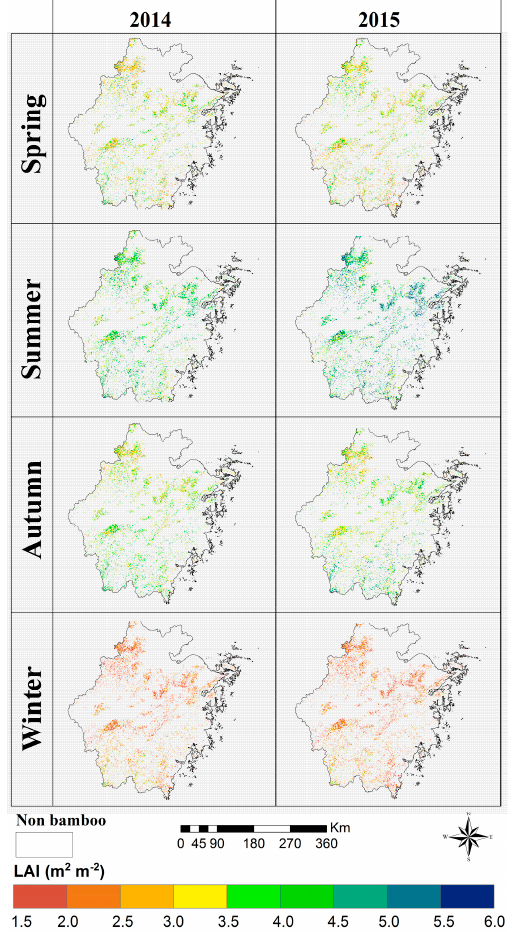
Figure 9. LAI assimilated by the PF algorithm in bamboo forests throughout Zhejiang Province.